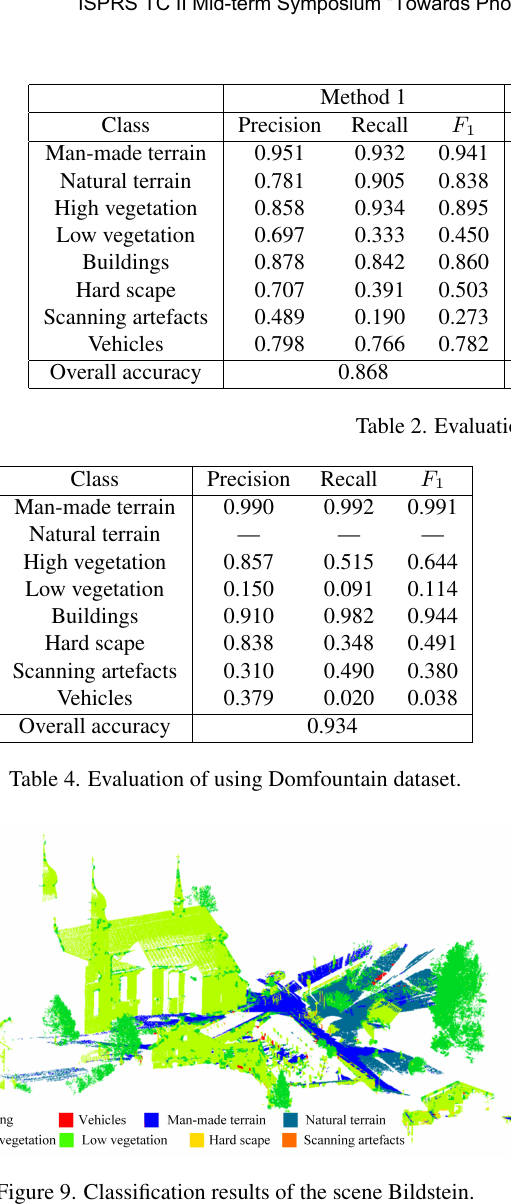
Figure 9. Classification results of the scene Bildstein.